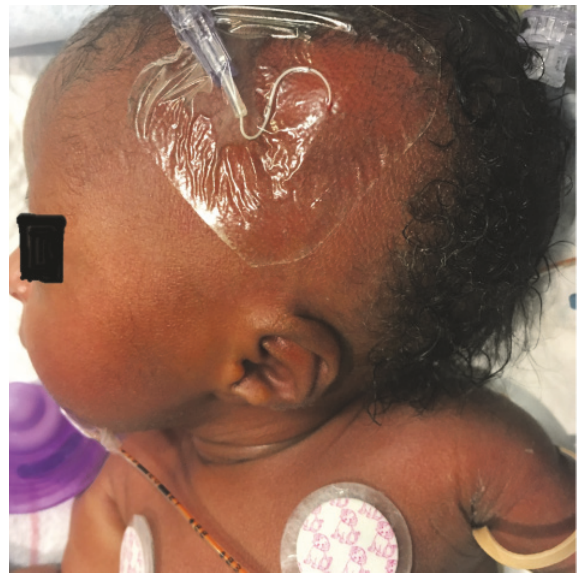
Figure 1: Photo showed low-set and posteriorly rotated ear.